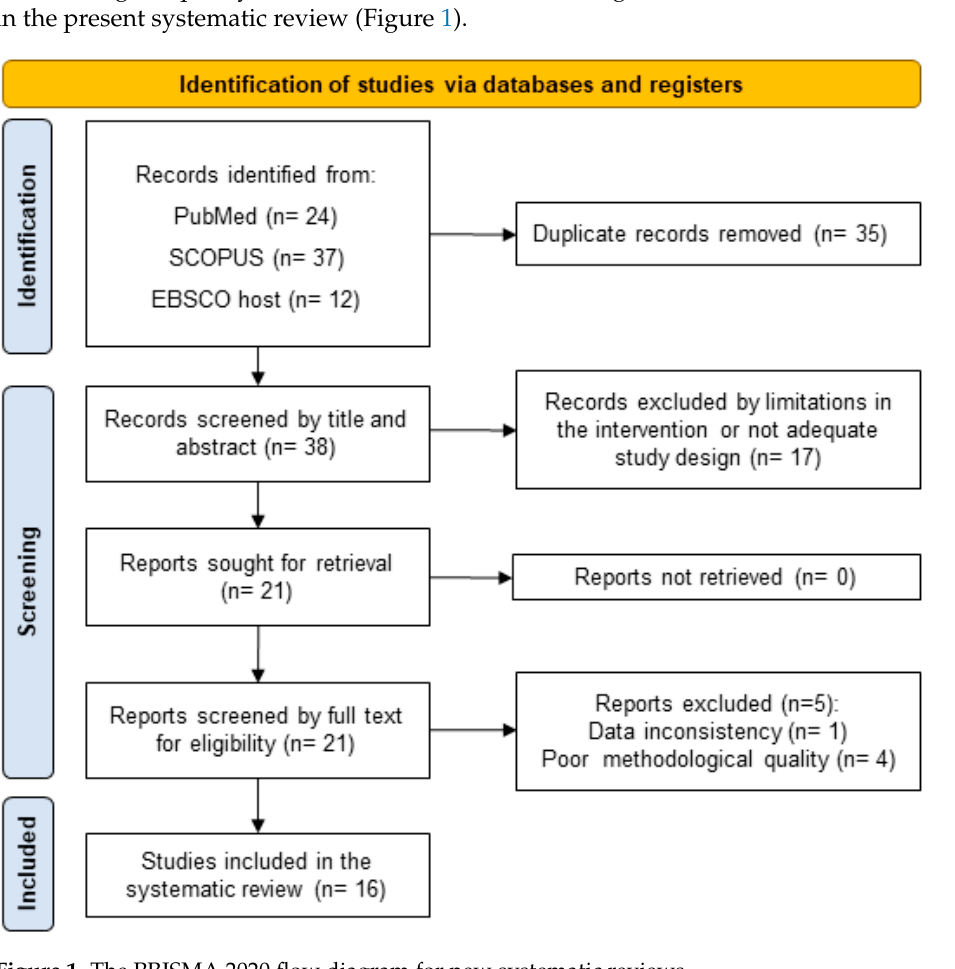
Figure 1. The PRISMA 2020 flow diagram for new systematic reviews.